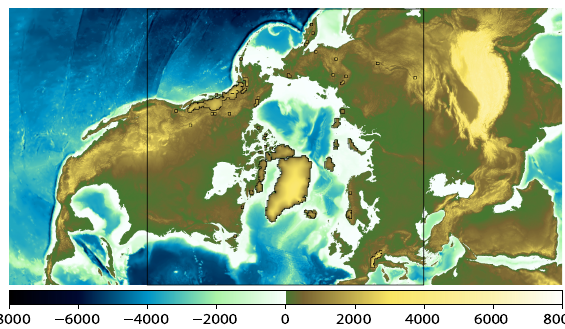
Fig. 2. HYDRO1kSP DEM (6.25km resolution) with superimposed present-day ice thickness from the embedded NHISM grid (black